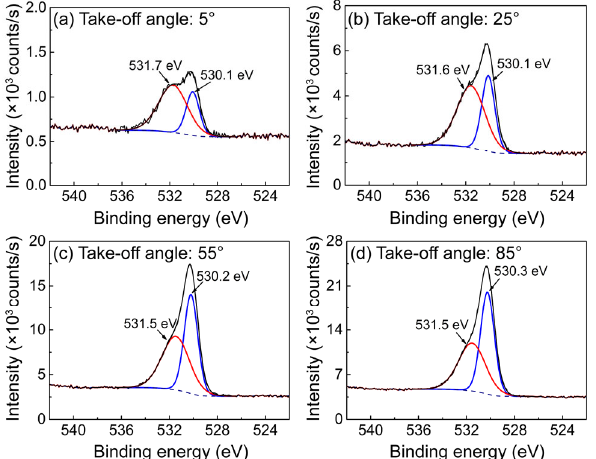
Fig. 6 XPS O(1s) spectra of the polished pure iron surface obtained at four different photoelectron take-off angles.